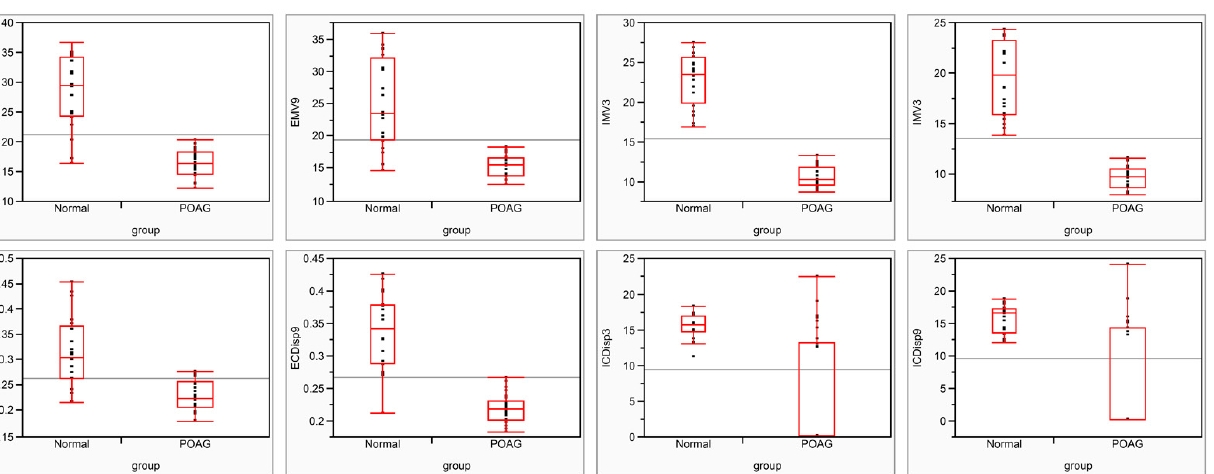
Table 3. The pulsatile TM motion in normal and POAG eyes.